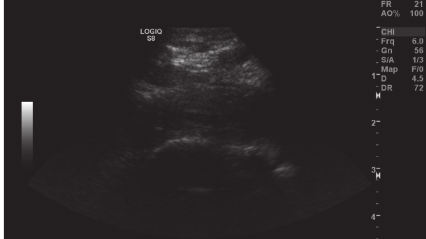
Figure 2: Right upper extremity ultrasound of a 25-year-old barista revealing acute thrombosis of the right central subclavian and axillary veins with compression by the first rib.